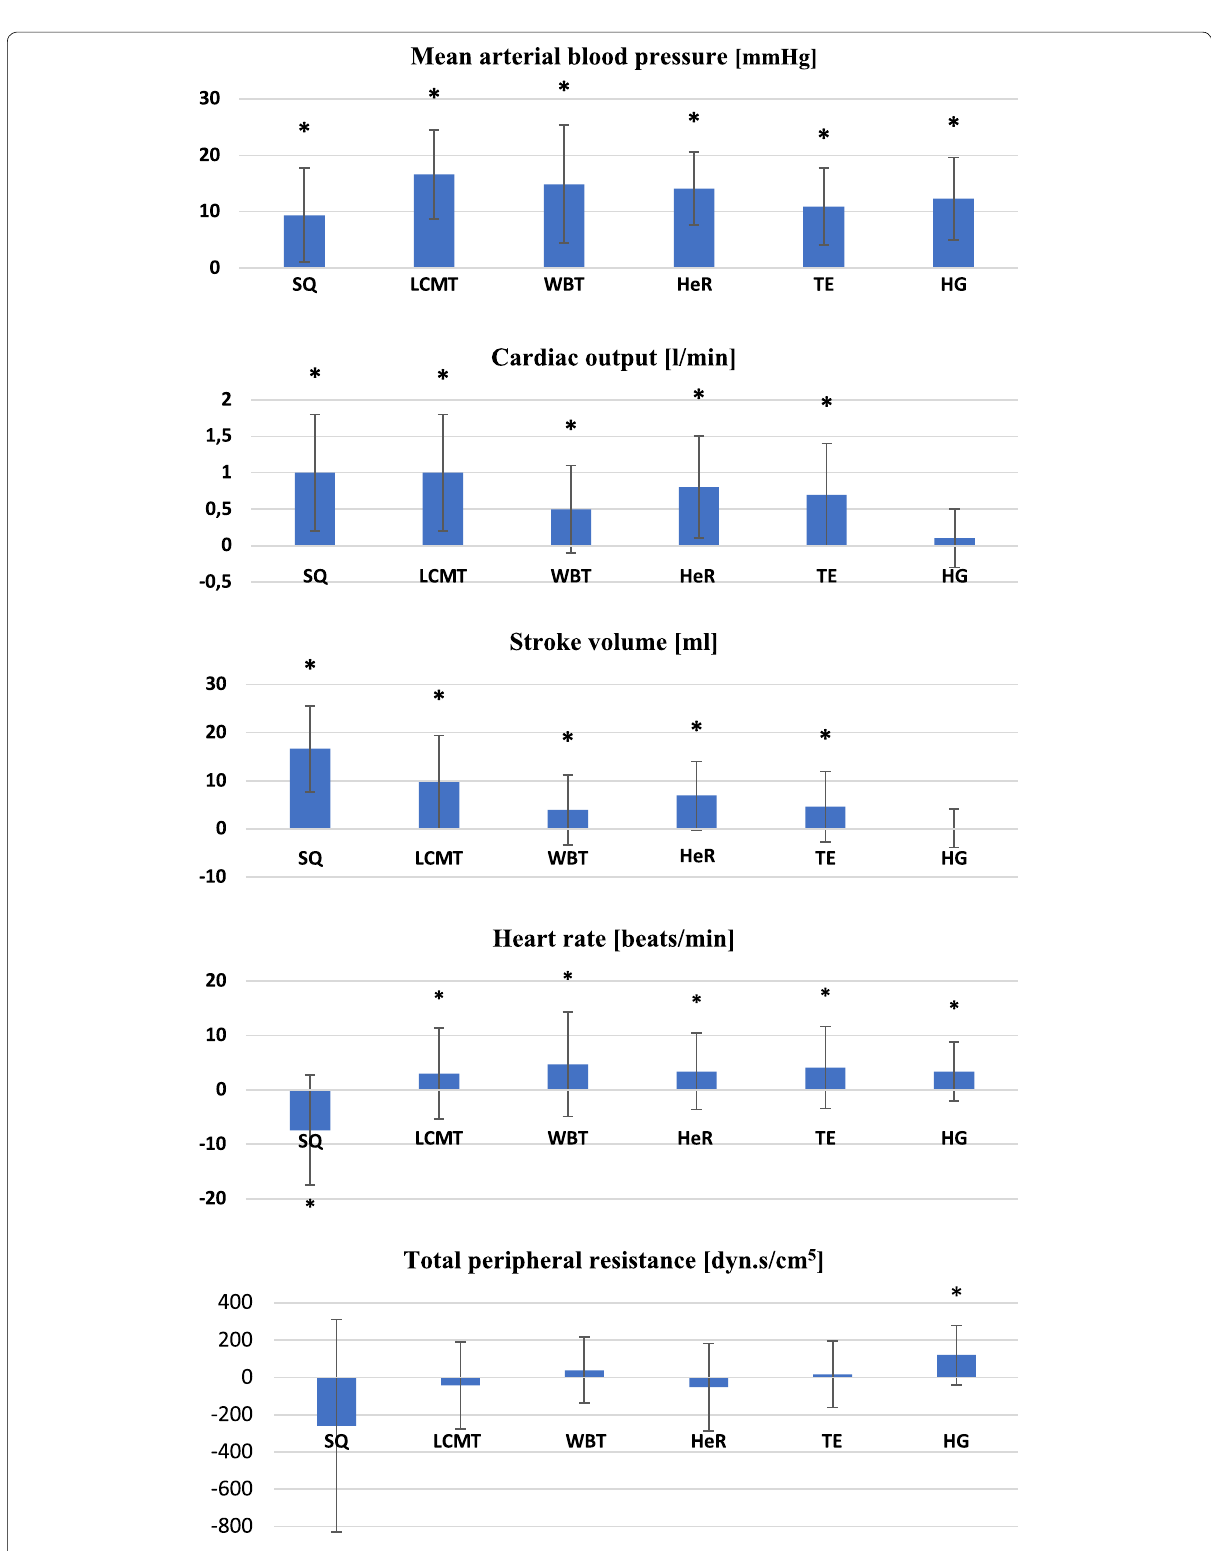
Fig. 3 Change in hemodynamic parameters during ICM (difference of values before and during ICM). SQ squatting, LCMT leg crossing and muscle tensing, WBT whole-body tensing, HR heel raising, TE toe extension, HG